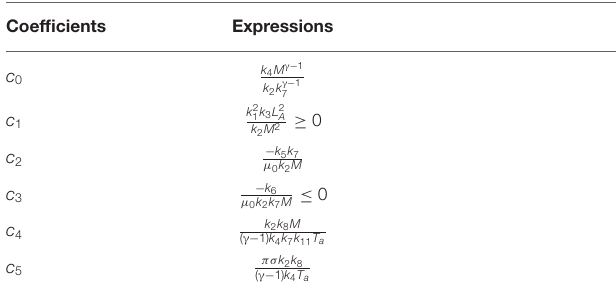
Top: The estimated thermodynamic parameters are scaled by the factors, i.e., Quantity = Factor × Value.Wenotethatthevariable, λ = L γ − 1 R γ − 1 ( a e − c 1 R -3 − c 2 LR − 3 − c 3 L -1 R -1 ). ThevaluesofLandRofthefluxropecanbemeasuredfromtheimagingobservations,and consequently the value of λ can be derived. γ is the adiabatic index (5/3 for monoatomic ideal gas), µ 0 is the magnetic permeability of free space, M is the total mass of a CME, and σ = ( γ − 1) m p 2 k , where m p is the proton mass and k is the Boltzmann constant. Middle: The constants k 2,7,8,11 > 0 while k 3,6,9,10 ≥ 0. These constants cannot be estimated from the FRIS model alone. Bottom: The coefficients (c 0-5 ) are also constants which can be estimated from the model. L A is the total angular momentum of a flux rope CME and T a is the equivalent temperature of the ambient solar wind around the CME.